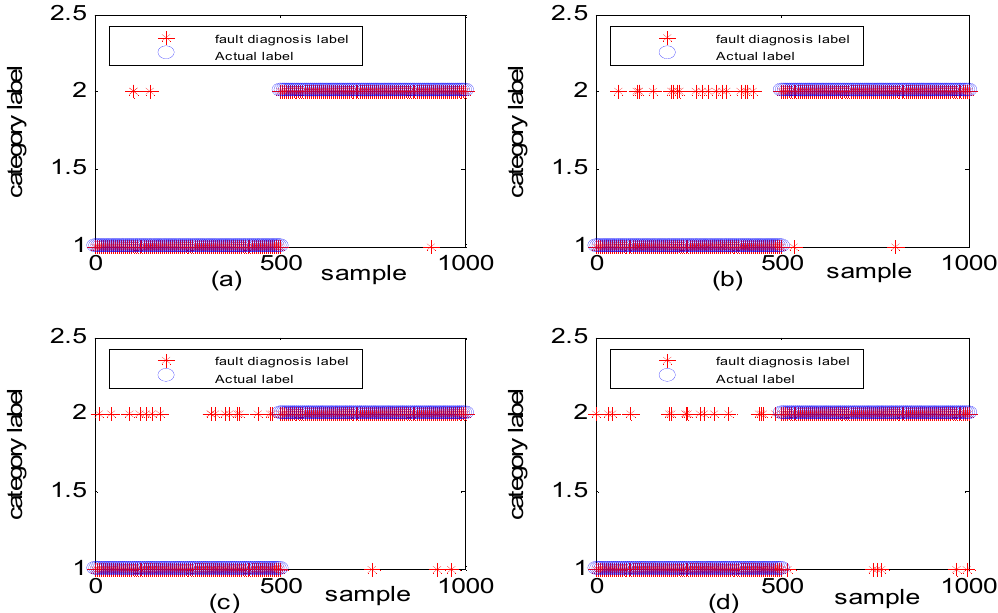
Figure 15. Simulation study for diagnosis of faults with different frequencies: ( a ) DGFFDNN, ( b ) DNN, ( c ) DGFFBP, and ( d ) BP. A red star represents the fault diagnosis label of each online sample, and a blue circle represents the real label of each sample. At each sample time, the coincidence of a red circle and a blue star means that the online observation at this sample time is correctly diagnosed.